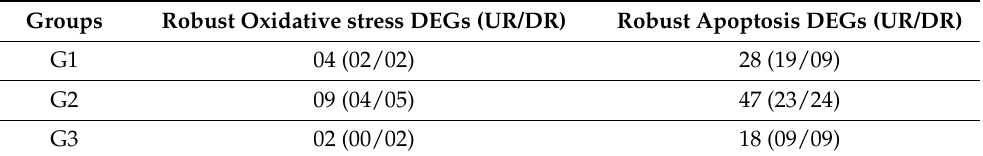
Table 5. Robust DEGs related to oxidative stress and apoptosis genes in all groups from Oncomine. Groups